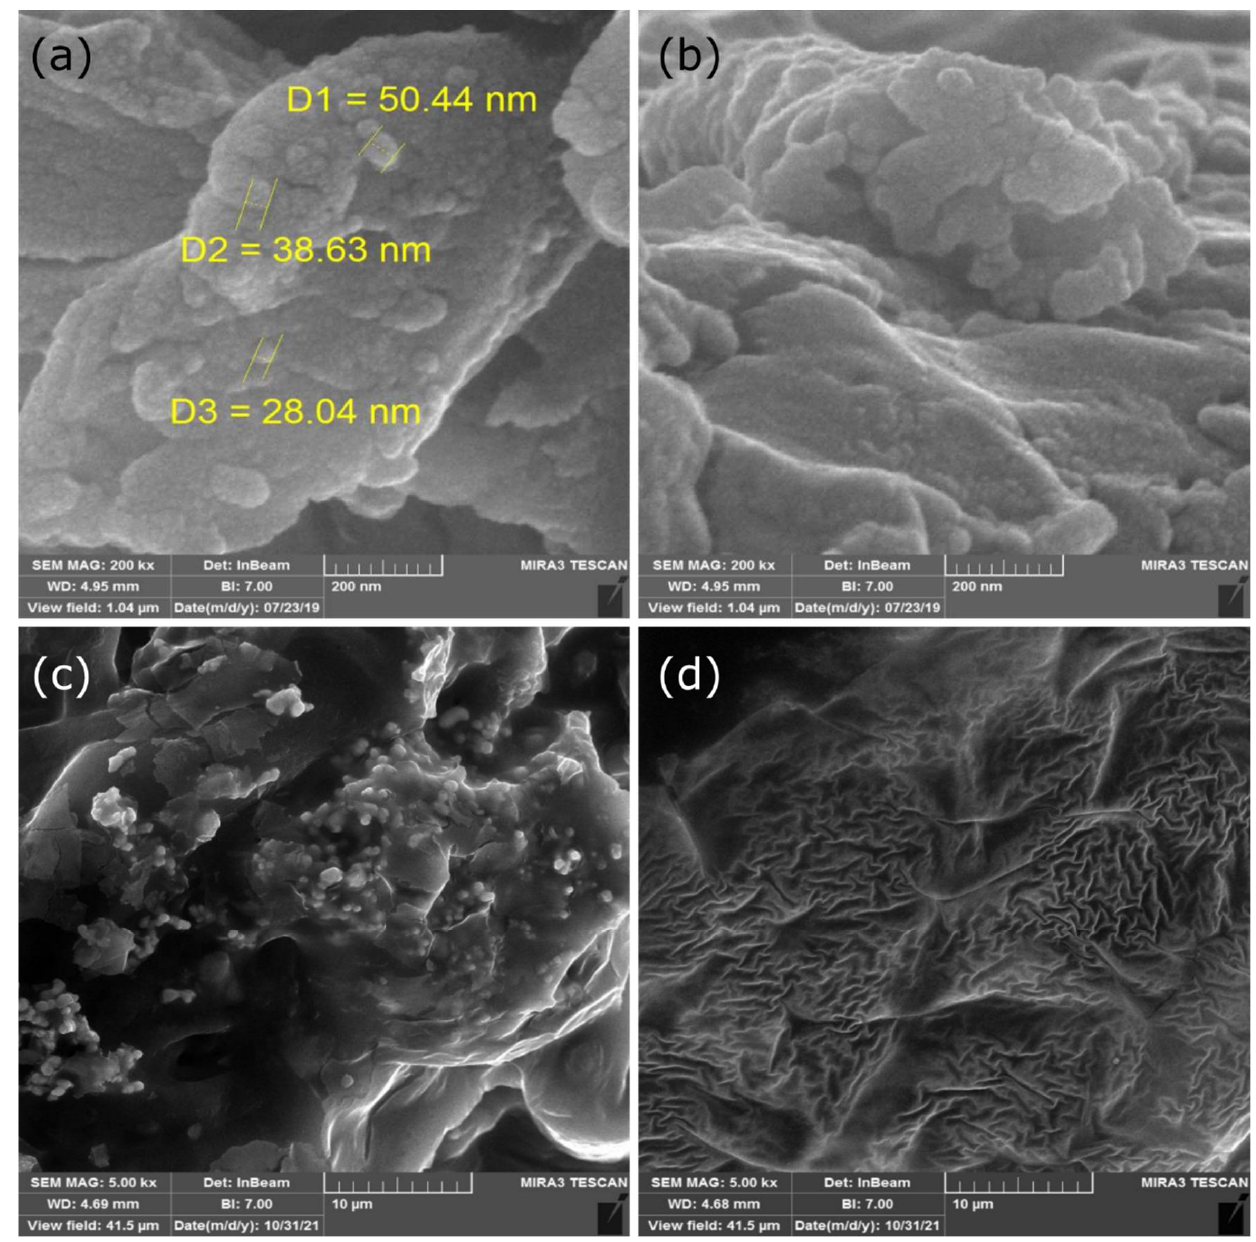
Figure 1. SEM images showing the microstructure of AVG-based edible coatings. ( a ) AVG (T1), ( b ) AVG + glycerol (T2), ( c ) AVG + glycerol + anthocyanin + 0.2% (T3), ( d ) AVG + glycerol + anthocyanin + 0.5% (T4). Scale bar: (a,b) = 200 nm, (c,d) = 10 µm. Magnifications: (a,b) 200,000×, (b,c) 5000×.